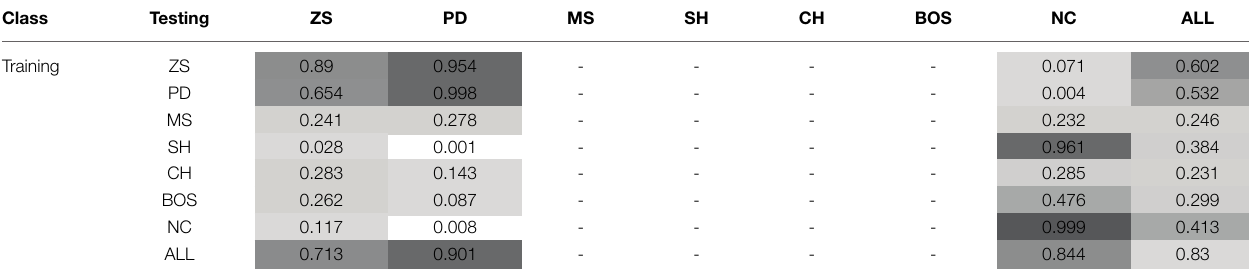
TABLE 5 | Joint probability of playing a PSNE (conditional on the training and test sets)—Games with a unique PSNE. Class